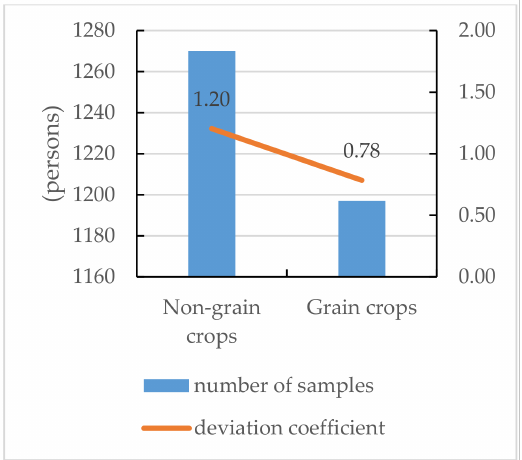
Figure 16. Deviation coefficient of agricultural machinery utilization rate grouped by crop